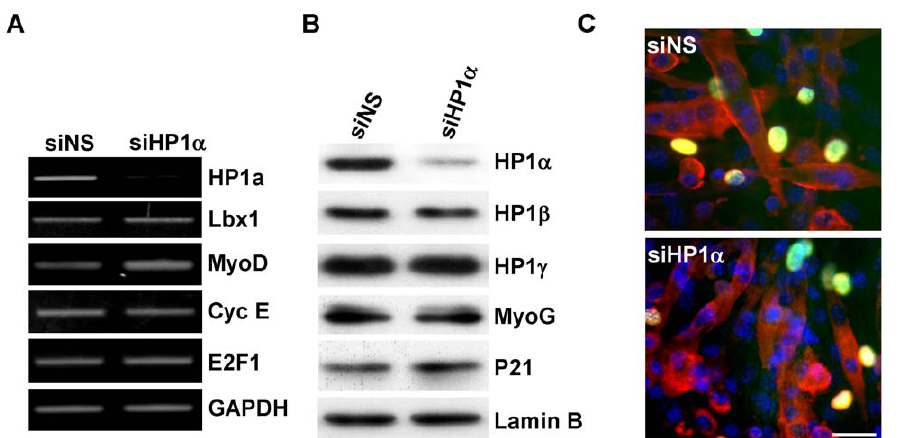
Figure 4. HP1 a is dispensable for maintenance of terminal differentiation. C2C12 cells were cultured in DM for 72 hours and then transfected with indicated siRNA. A , 48 hours after transfection, total RNA was isolated and semiquantitative PCR analysis of gene expression was performed. B. 24 hours after siRNA transfection, DMEM contain 20% FBS were added and cells were cultured for another 24 hours. Total protein were extracted and probed for indicated antibodies. C. 24 hours after siRNA transfection, cells were stimulated with DMEM contain 20% FBS in the presence of BrdU for 24 hours. Cell cycle reentry was determined by immunostaining for BrdU incorporation (Blue: DAPI, Red: sarcomeric myosin heavy chain; Green; BrdU). Scale bar equals 50 m